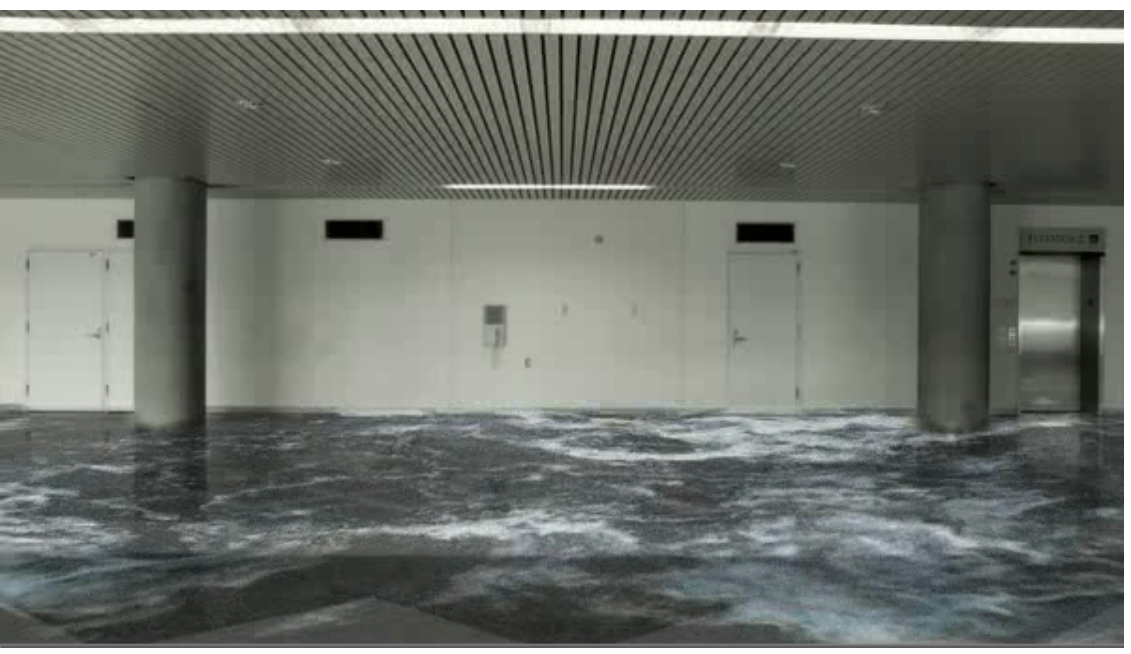
Figure 1: Installation of Marina Zurkow’s Paradoxical Sleep (2008) in the San Jose McEnery Convention Center, San Jose, California, United States. Image courtesy of the artist and bitforms